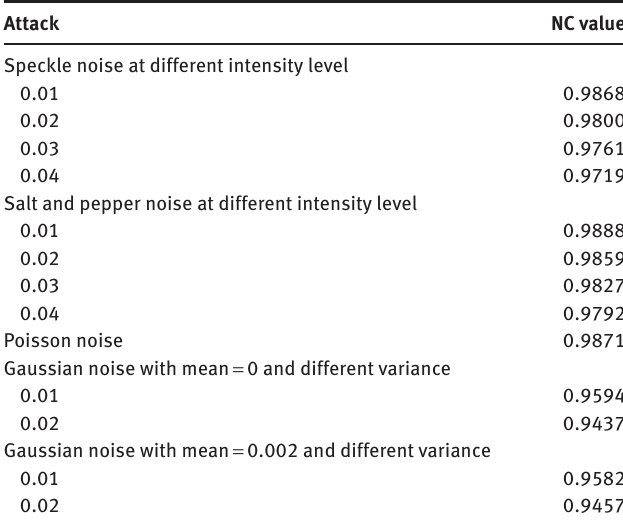
Table 5: NC Performance Against Attacks at Gain = 0.1. Attack NC value Speckle noise at different intensity level 0.01 0.9868